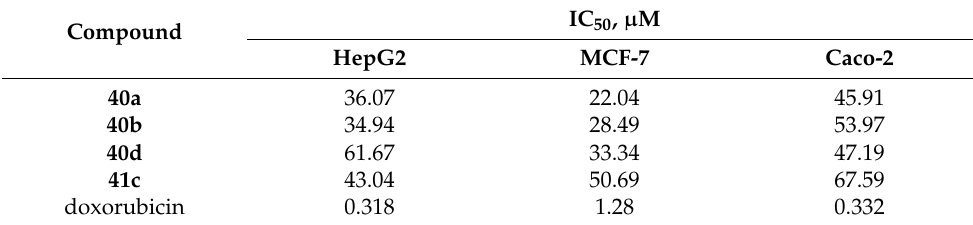
Table 5. The cytotoxic activity of bis-thiazolidin-4-ones against HepG2, MCF-7 and Caco-2 cell lines.